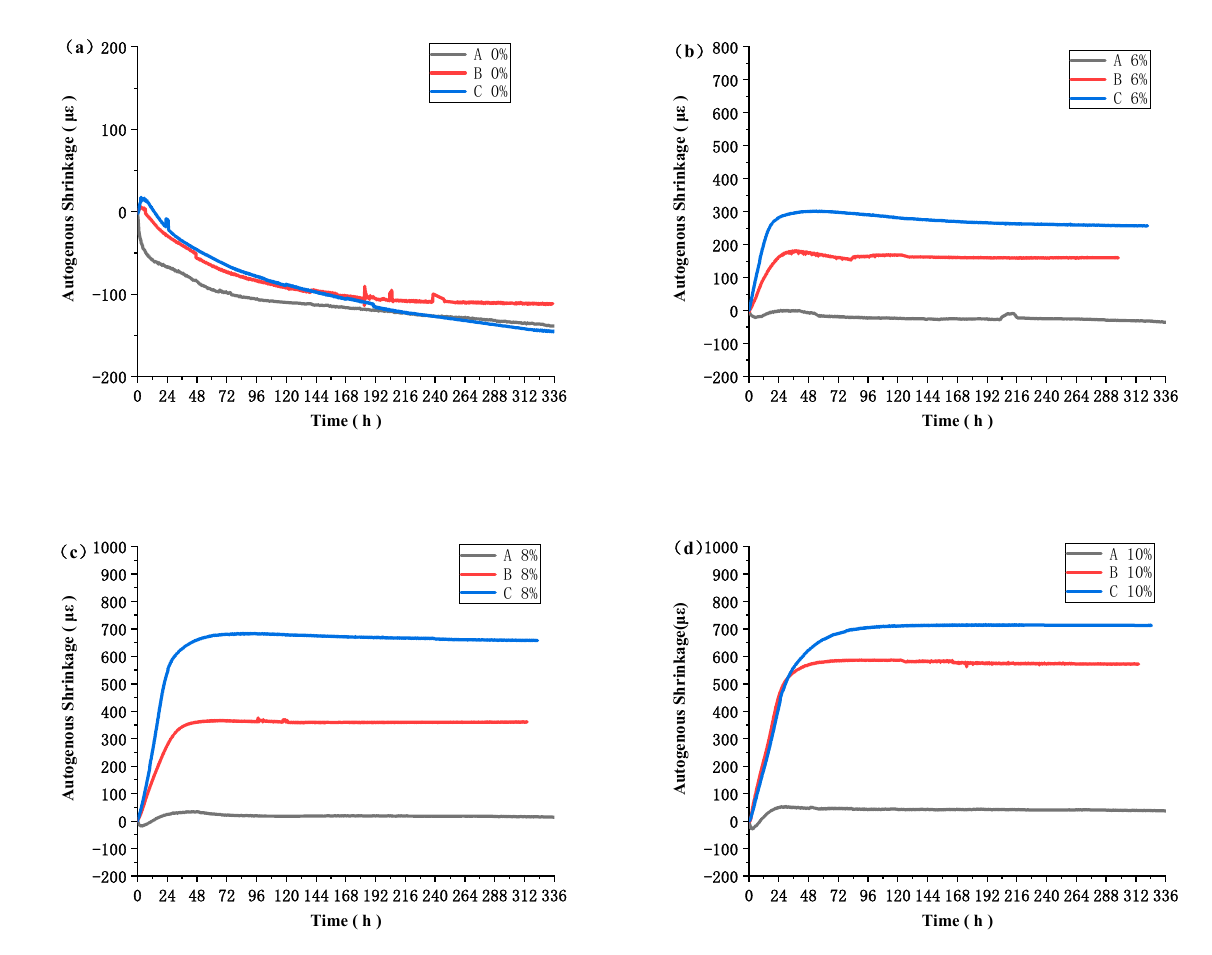
Figure 7. E ff ect of MEA content on early autogenous deformation of concrete at di ff erent tempera- ture conditions. ( a ) Autogenous deformation at temperature A; ( b ) Autogenous deformation at tem- perature B; ( c ) Autogenous deformation at temperature C.